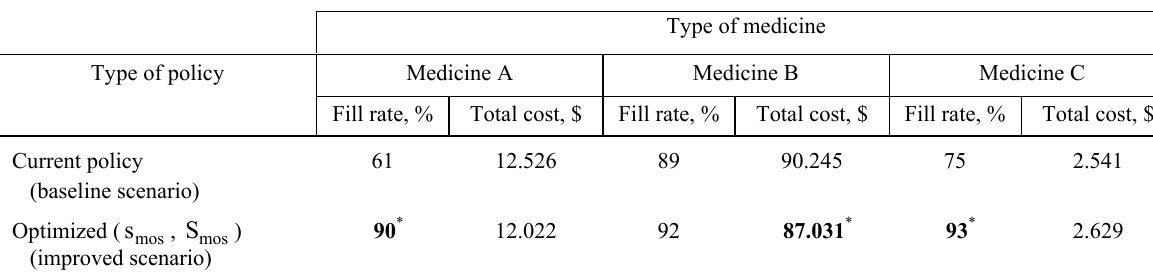
Table 3. Simulation